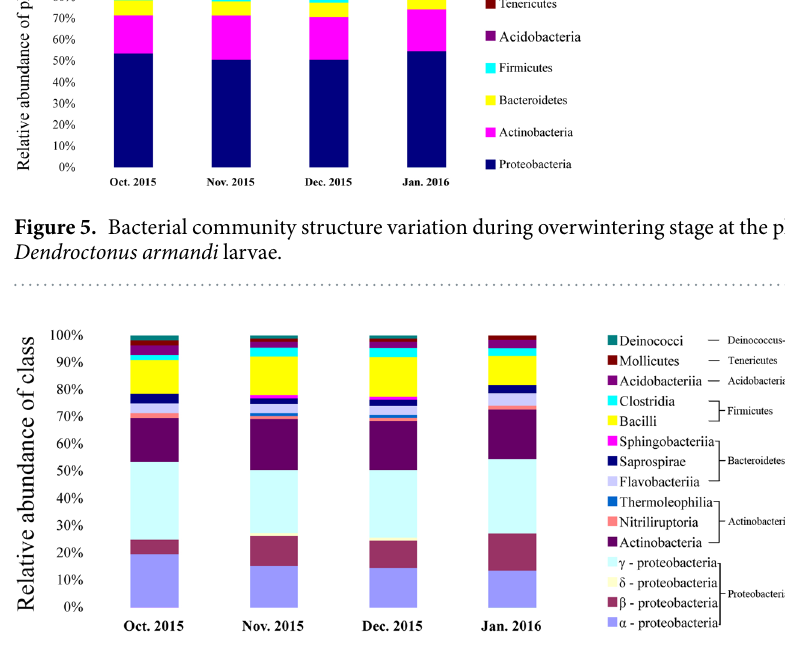
Figure 6. Bacterial community structure variation during overwintering stage at the class level of Dendroctonus armandi larvae.